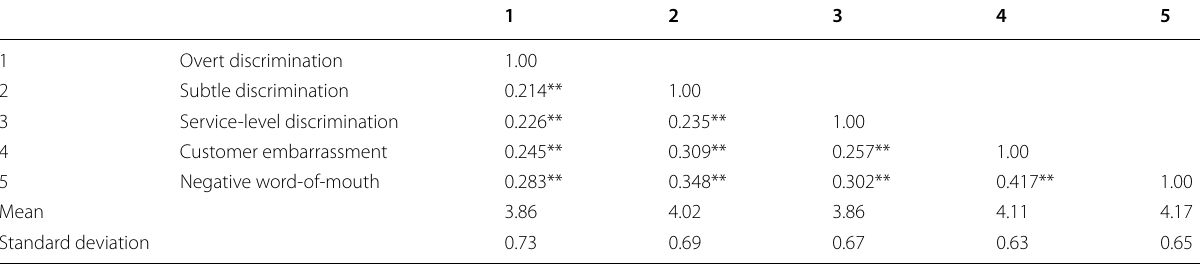
Table 2 Mean, standard deviation, and